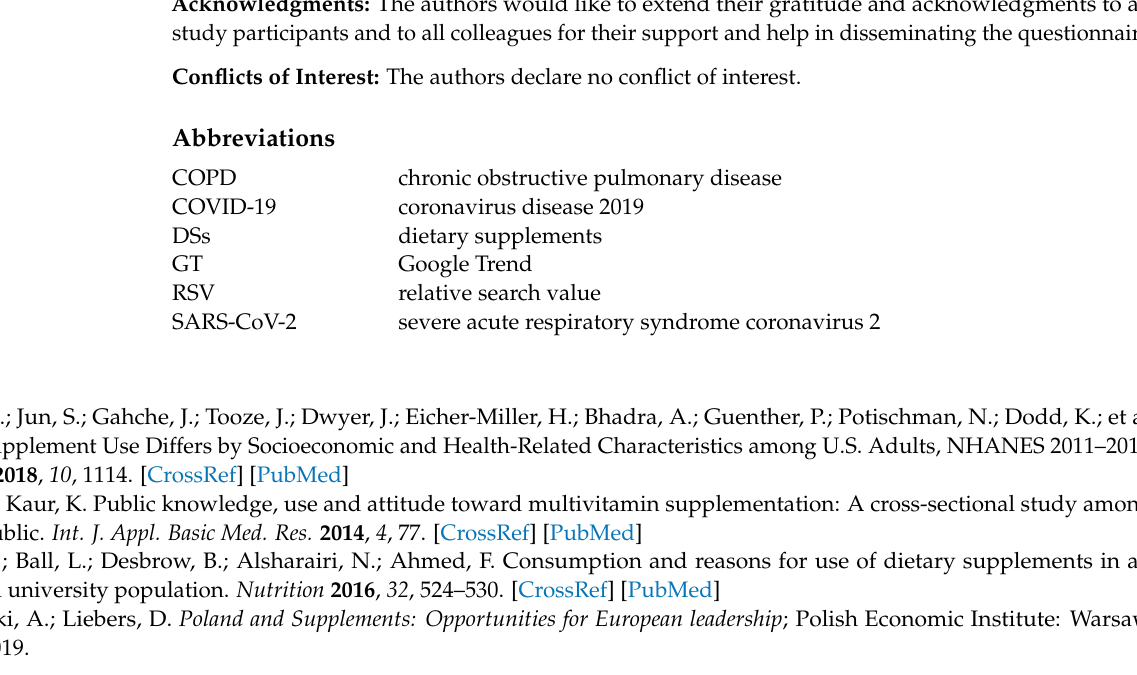
Figure S5. Source of knowledge about dietary supplements usage—results of PLifeCOVID-19 Online Study 2 ( n =